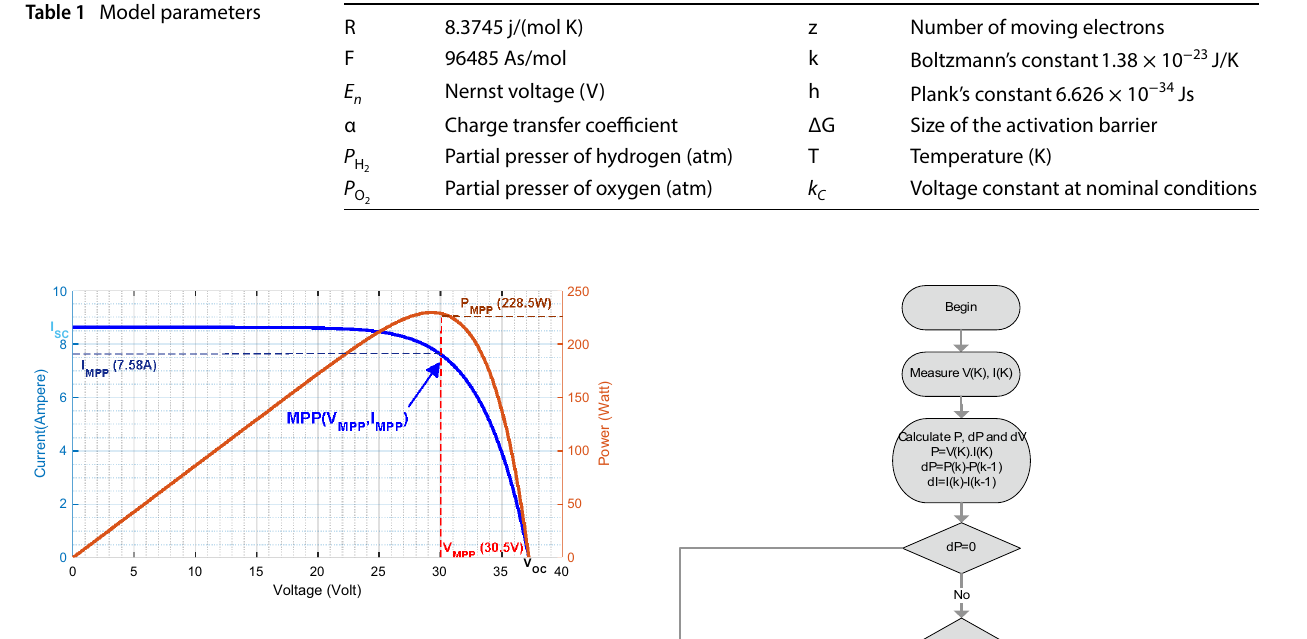
Fig. 4 I–V and P–V characteristics graphs of the proposed solar panel for T = 25° and rad = 1000 W/m 2